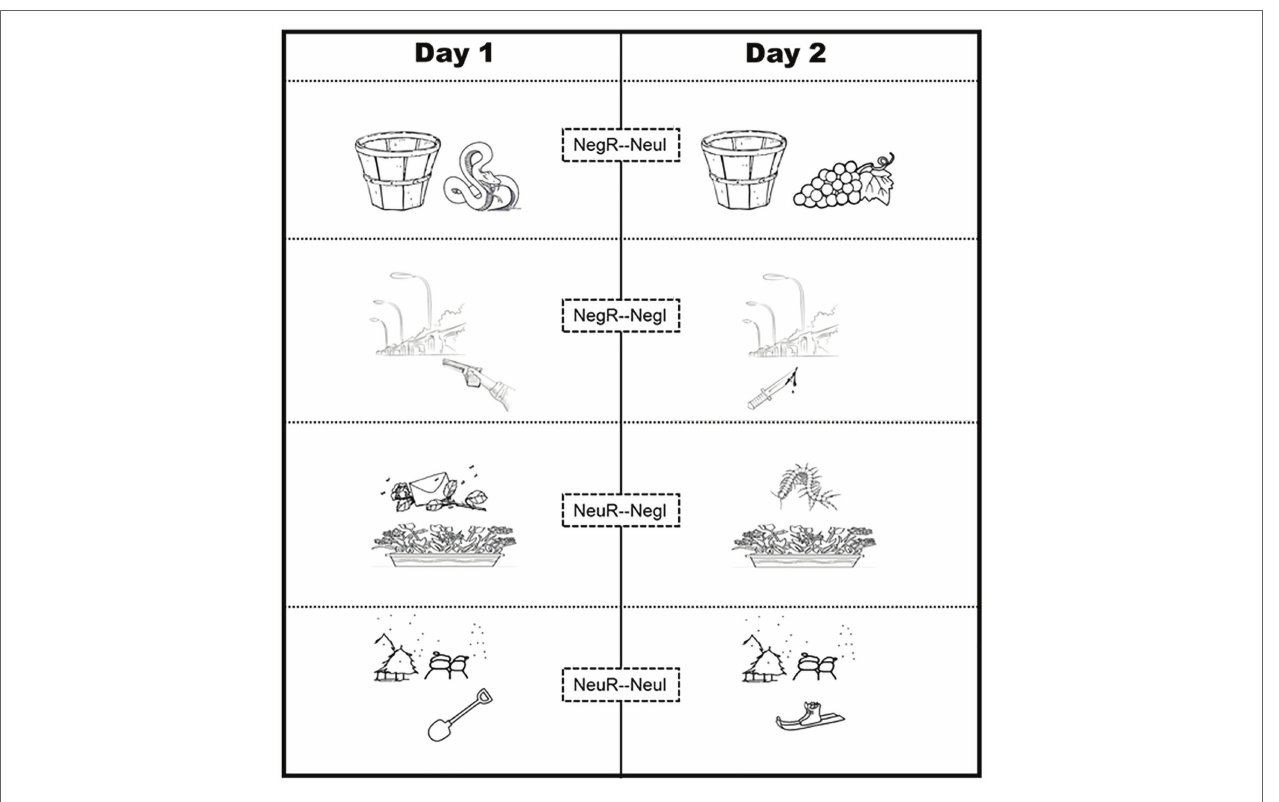
FIGURE 3 | Example materials under four conditions in Experiment 2. All learning (Day 1)/interfering (Day 2) materials consisted of the cue object and the core object (which actually determine the core valence of the scenario). For all background cues from Day 1 neutral scenarios, half was matched with Day 2 neutral interference objects to form novel neutral scenarios and half was matched with Day 2 negative interference objects to form novel negative scenarios. The same matching rule applied 32 background cues from Day 1 negative scenes. Thus, all scenarios (on Day 1) were actually divided into four categories: (a) Negative origin with Neutral interference (NegO-NeuI); (b) Negative origin with Negative interference (NegO-NegI), (c) Neutral origin with Neutral interference (NeuO-NeuI), and (d) Neutral origin with Neutral interference (NeuO-NeuI). Within-subject design, thus, can be used to more sensitively investigate the effects of original memory valence and interference valence on memory